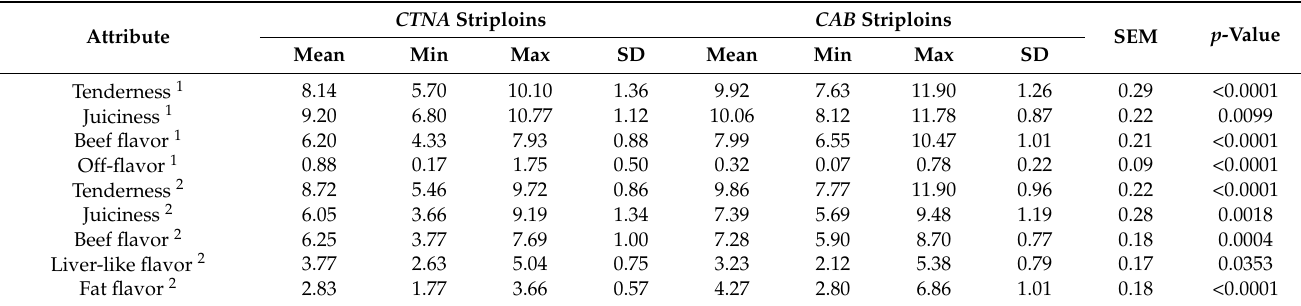
Table 3. Descriptive statistics and mean comparison of sensory descriptive ratings for striploins derived from PGI-Certified Ternera de Navarra ( CTNA ) and Certified Angus Beef ( CAB ) as tested by trained panels in Spain and the USA, respectively.